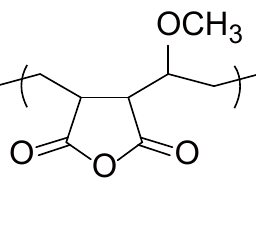
Figure 6. Chemical structure of poly(maleic anhydride)- co -poly(methyl vinyl